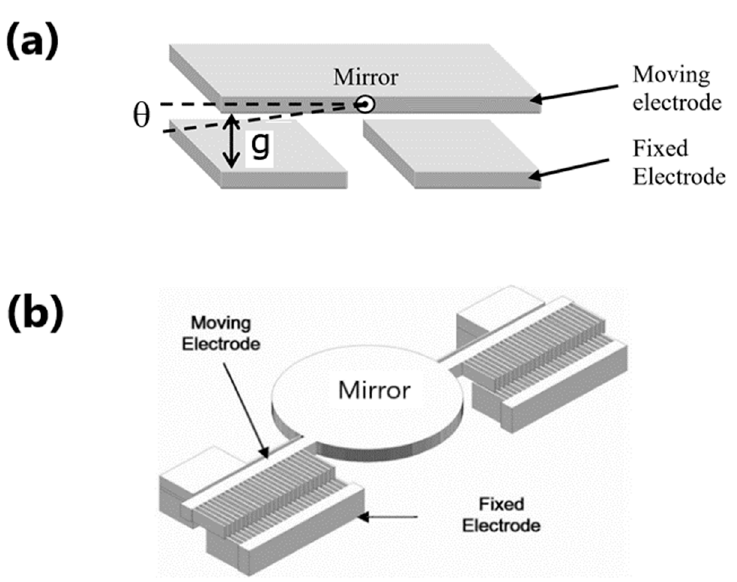
Figure 8. Two main architectures of electrostatic actuation: ( a ) parallel-plate actuator and ( b ) comb-drive actuator.